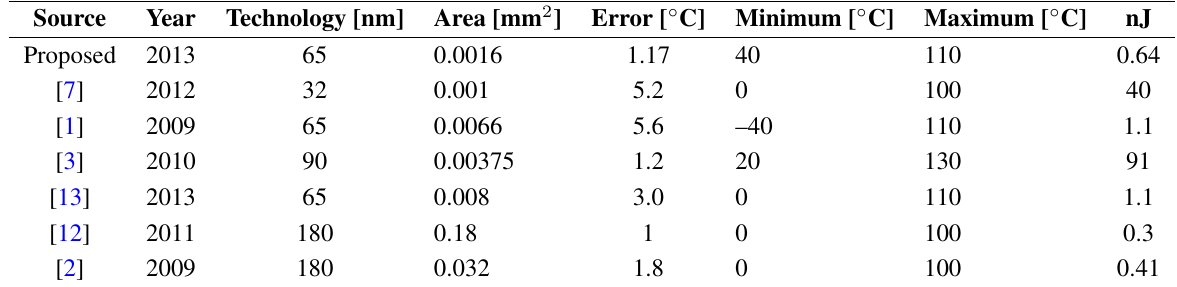
Table 2. Previous works